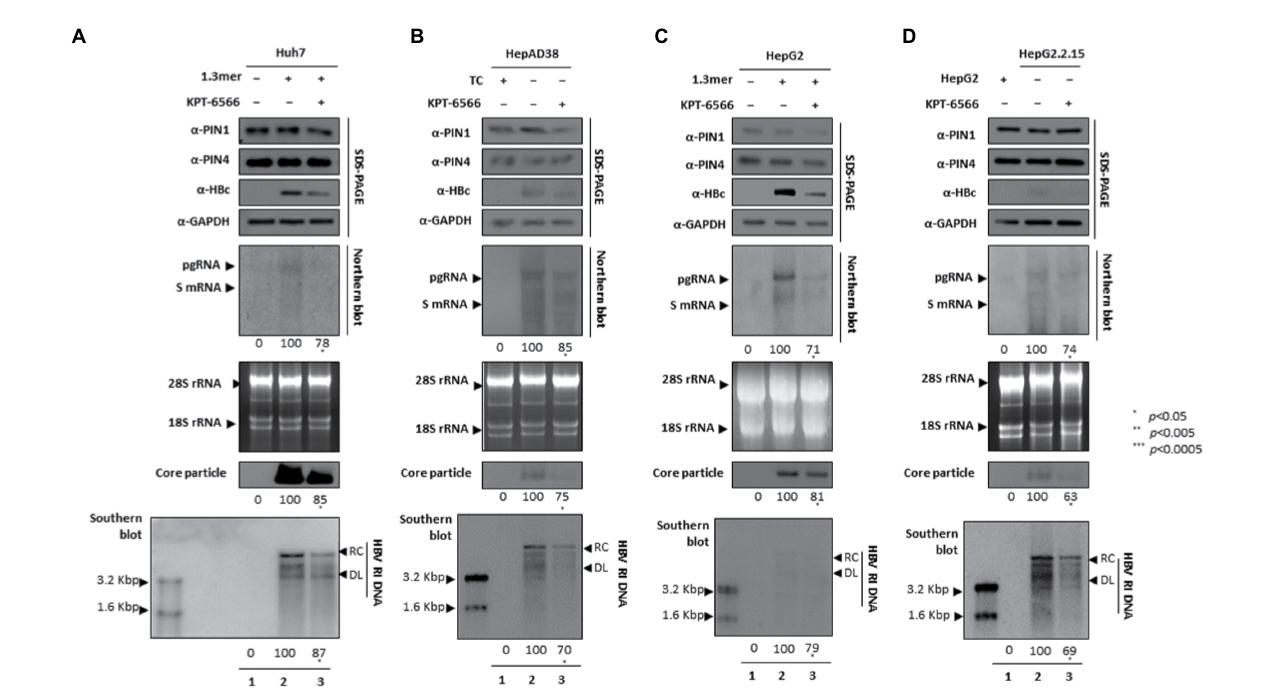
FIGURE 7 KPT-6566 mediated inhibition of PIN1 and PIN4 lowered HBV replication in Huh7, HepAD38, HepG2, and HepG2.2.15. (A–D) KPT-6566 reduced HBV replication. (A) The Huh7 cells were mock-transfected (lane 1), transfected with 4 μ g of 1.3 mer HBV WT and treated with DMSO (lane 2), or transfected by 1.3 mer HBV WT (4 μ g) and treated with 30 μ M of KPT-6566 for 72 h (lane 3). (B) HepAD38 was treated with mock (none, lane 1) or DMSO (lane 2), or treated with